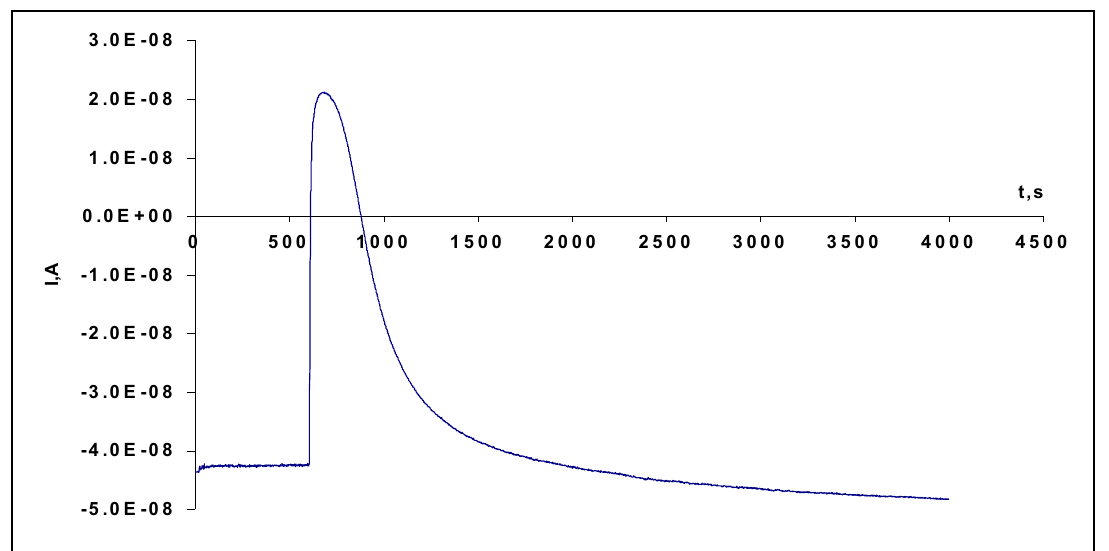
Figure 7. Time dependence of current through the membrane in response to 3.5 mM Tween 20. 0.45 µm nitrocellulose fi lter impregnated with isopropyl myristate separated by a 5 mM bu ff er+ 0.5 M KCl and a 5 mM bu ff er.